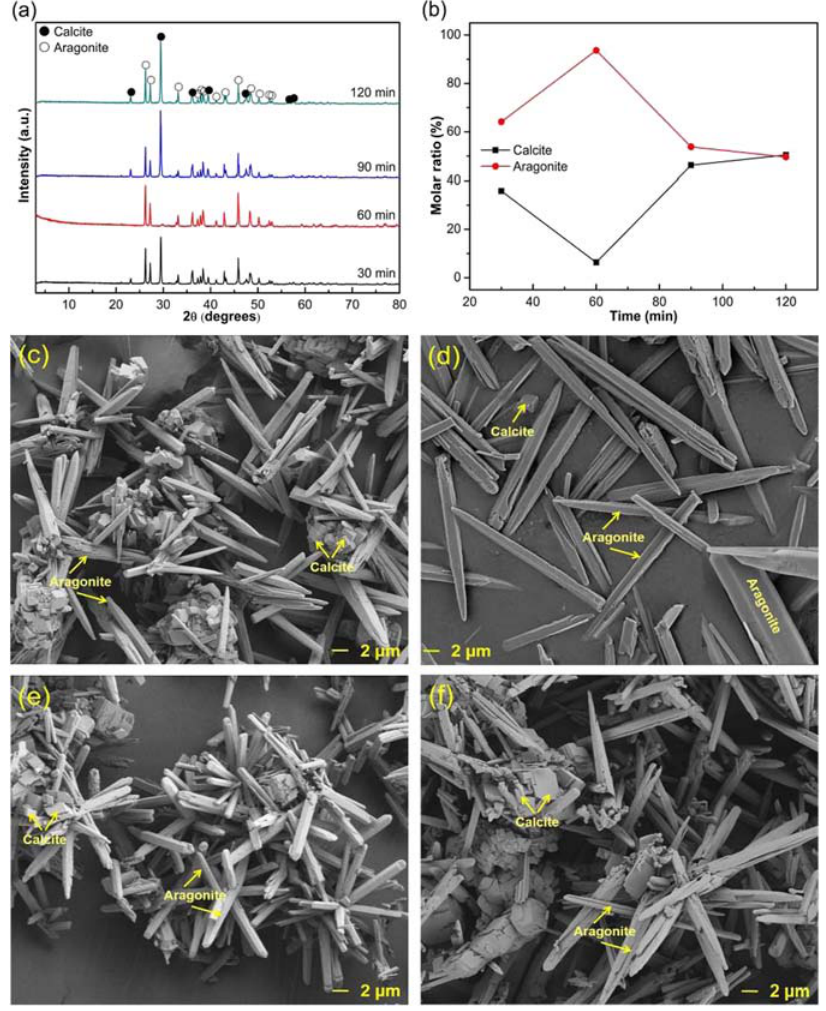
Figure 6: E ff ect of reaction time on crystal phase and morphology: ( a ) XRD patterns of the product, ( b ) composition of the products calcite and aragonite, and SEM images of the product: ( c ) 30 min, ( d ) 60 min, ( e ) 90 min, and ( f ) 120